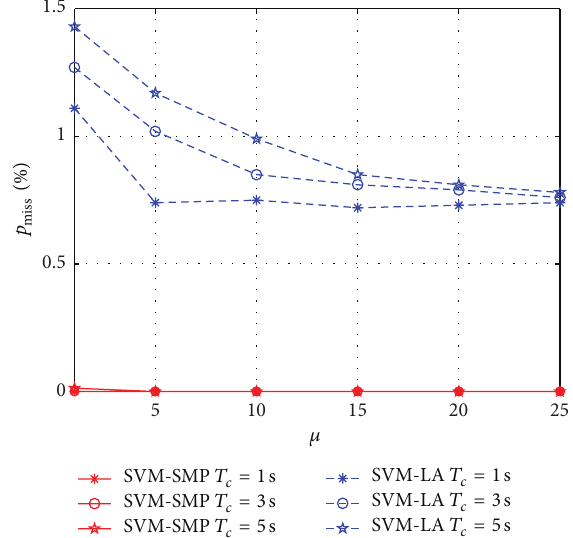
Figure 11: Miss prediction rate 𝑝 SUs’ randomness movements of different strength for 𝑝